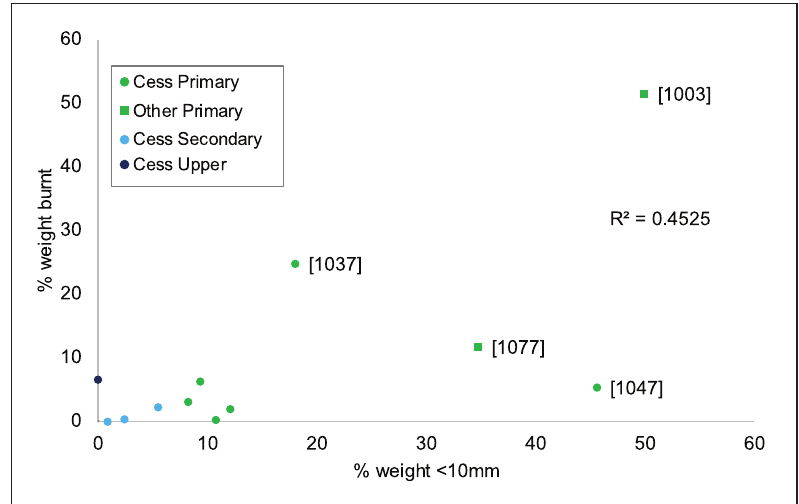
Figure 2: Proportion of bones showing evidence of heat exposure (by weight) against the proportion of the assemblage weight <10mm in maximum dimensions in each